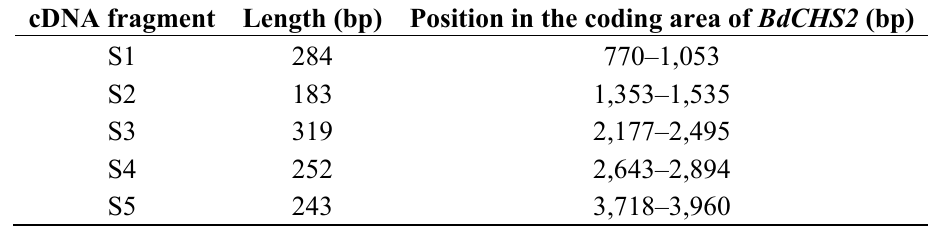
Table 1. The cDNA fragments of BdCHS2 extracted from a transcriptome sequencing data of B. dorsalis .